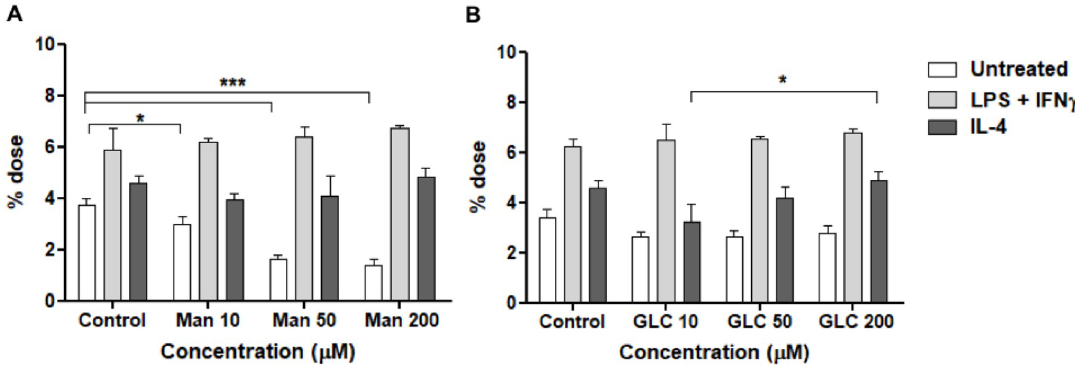
Fig 7. Cell uptake of 99m Tc-HYNIC-dendrimer-mannose-Cy7 with block. (A) BMDMs uptake of 99m Tc-HYNIC-dendrimer- mannose-Cy7, cells treated with different concentrations of D-mannose. (B) BMDMs uptake of 99m Tc-HYNIC-dendrimer-mannose- Cy7, cells treated with different concentrations of D-glucose. Data are expressed as % dose (mean ± SD). A comparison in each group was performed by two-way ANOVA followed by the Bonferroni test ( � p < 0.005). Ctr (control), Man (mannose), Glc (glucose).